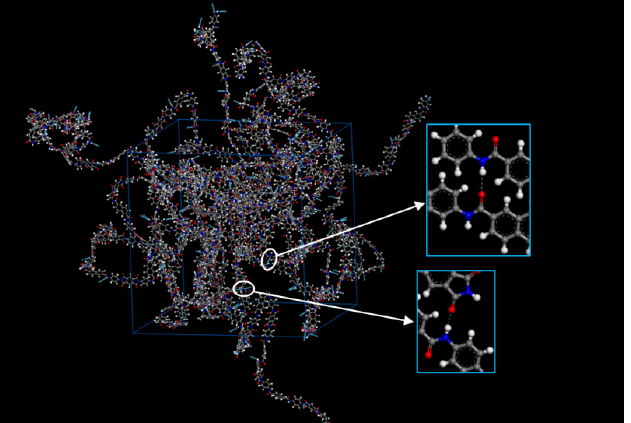
Figure 10. Hydrogen bonds in NAPPI amorphous cell (C, N, O and H are displayed in gray, blue, red, and white respectively, hydrogen bonds are shown as blue dotted lines).